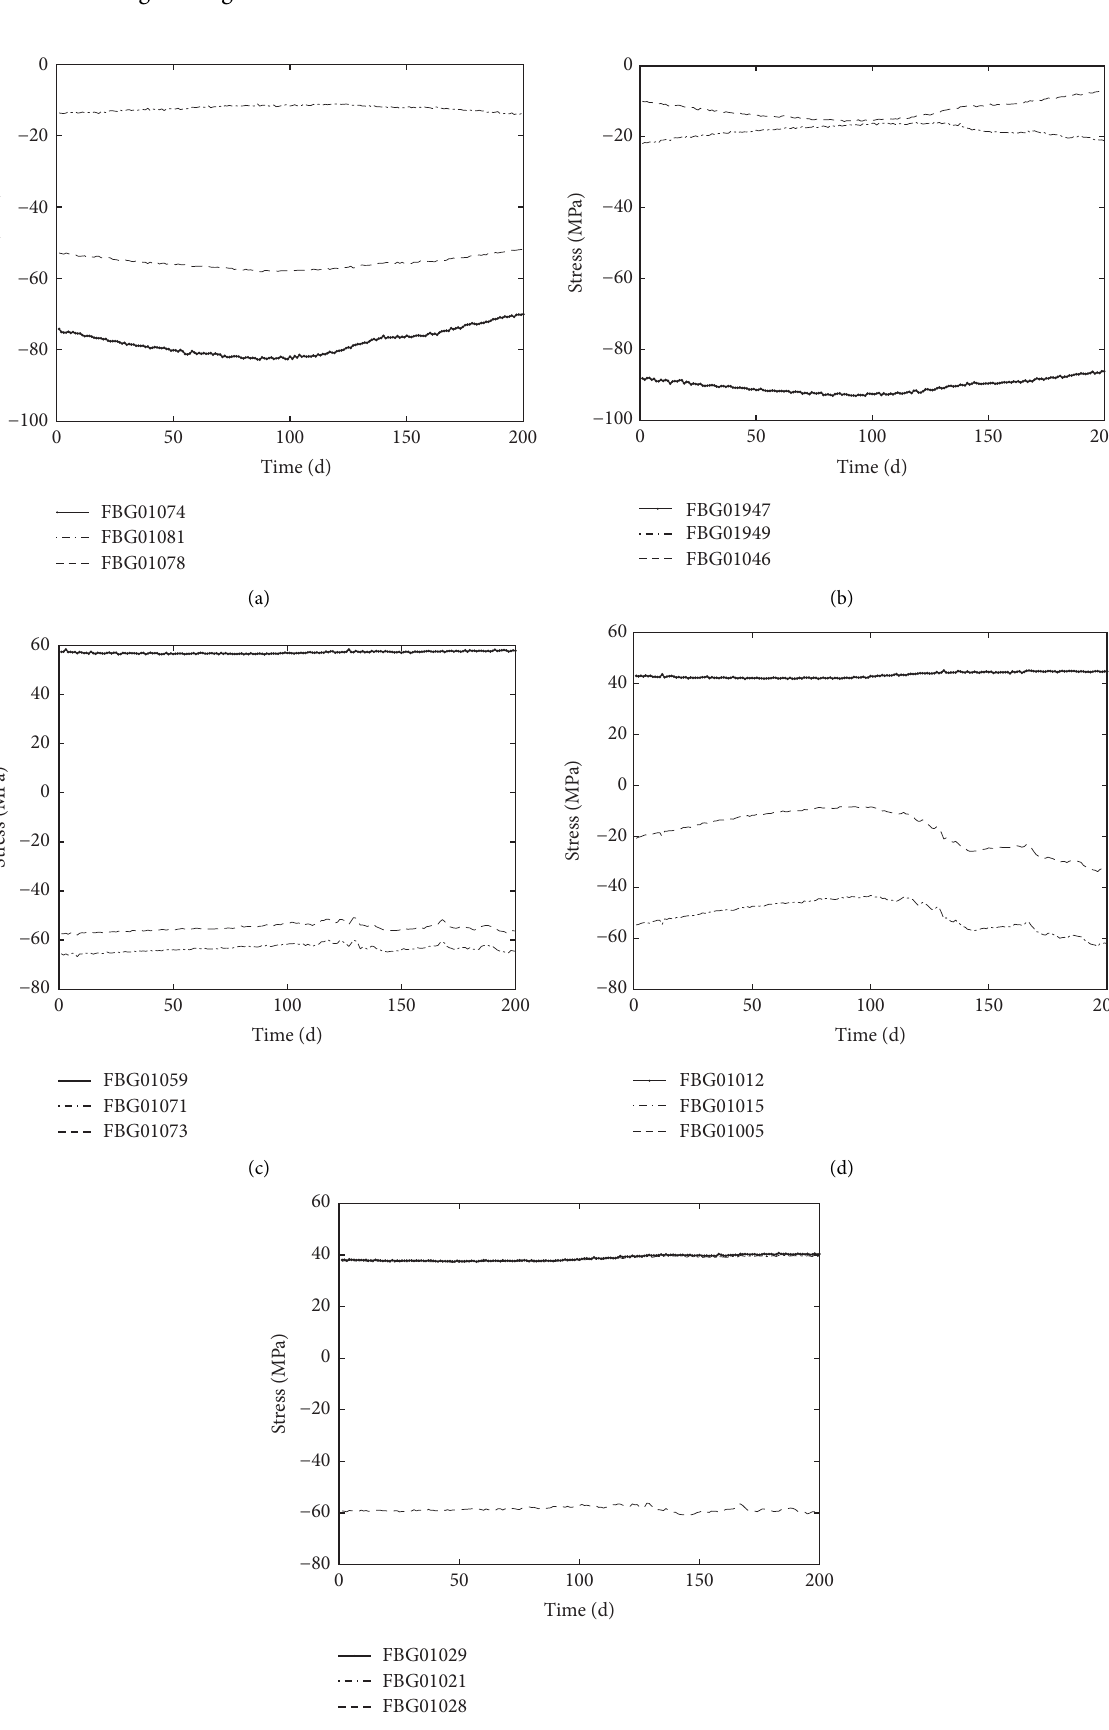
Figure 5: Monitoring extreme stresses of the five sections. (a) Section A. (b) Section B. (c) Section C. (d) Section D. (e) Section